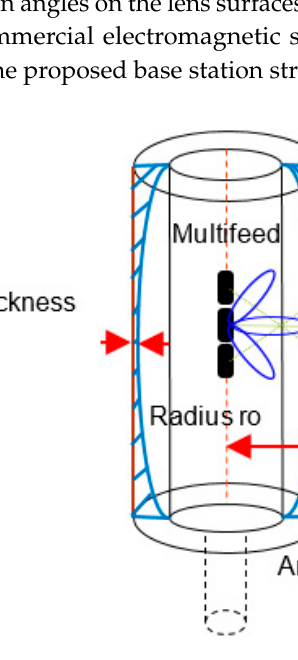
Figure 1. Proposed mobile base station structure.